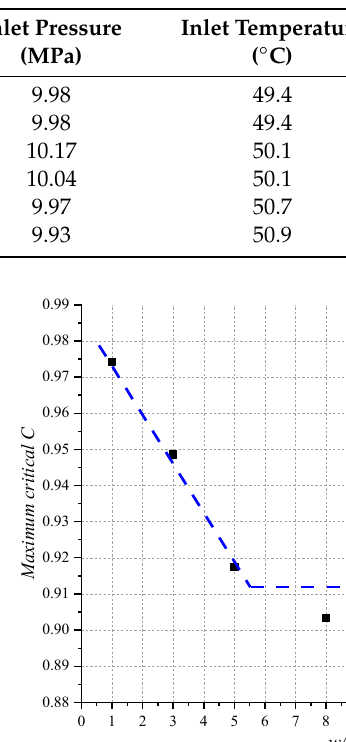
Table 4. The results of single round-hole with different w / c.